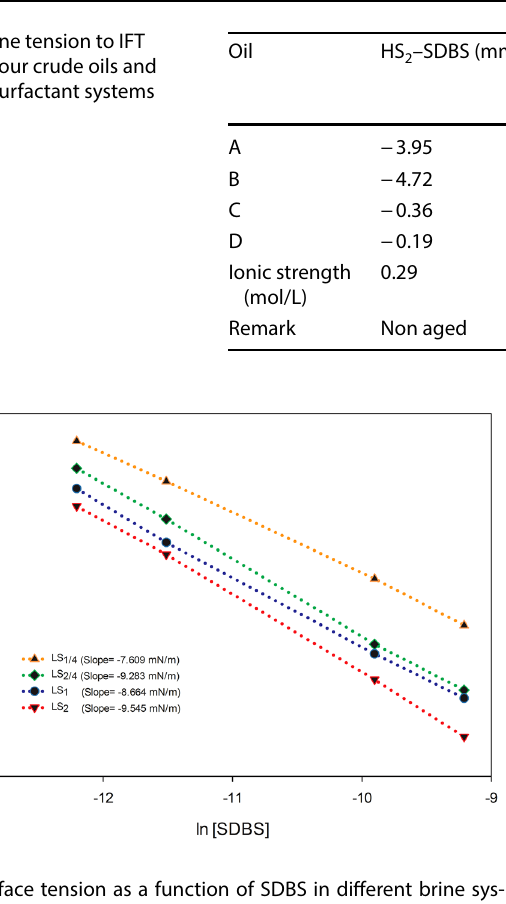
Fig. 8 Surface tension as a function of SDBS in different brine sys- tems